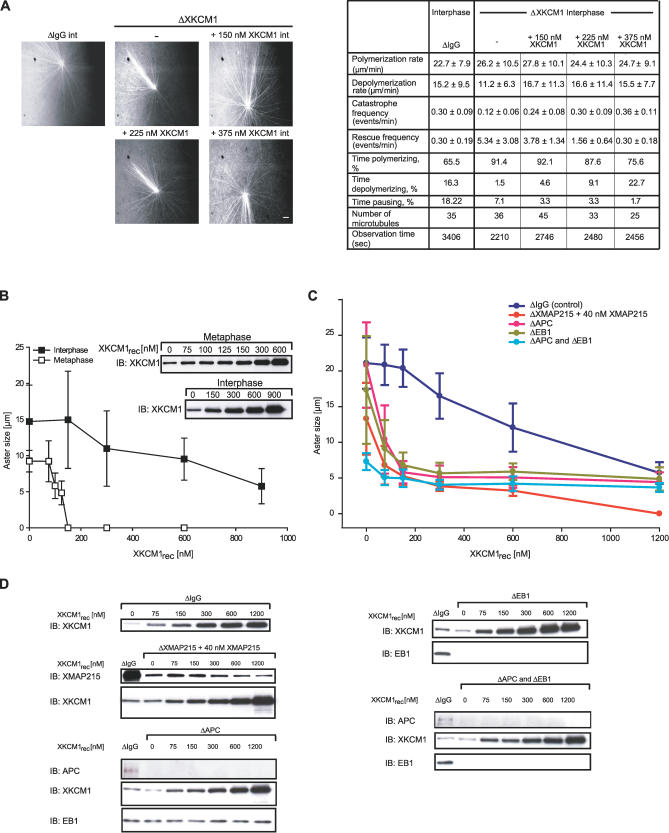
The MT Destabilizing Activity of XKCM1 Is Inhibited by MAPs in Interphase Egg Extracts(A) Still images and table summarizing the dynamic parameters of MT growth in response to XKCM1 depletion (ΔXKCM1) and add back of the recombinant protein.(B) Aster size after stepwise addition of recombinant XKCM1 into undepleted interphase and metaphase extracts. Error bars represent the S.D. (n > 30). Inset shows the Western blot of extracts containing increasing amounts of recombinant XKCM1 (XKCM1rec = amount of XKCM1 added in nM; and IB: XKCM1 = immunoblot with anti-XKCM1 antibody).(C) Aster size after stepwise addition of recombinant XKCM1 into control (IgG) depleted (indigo line), XMAP215 depleted plus 40 nM XMAP215 (red line), APC depleted (pink line), EB1 depleted (dark yellow line), and APC and EB1 depleted (cyan line) interphase extracts. Error bars represent the S.D. (n > 30).(D) Western blot of extracts containing increasing amounts of recombinant XKCM1 (XKCM1rec = amount of XKCM1 added in nM; and IB: XKCM1 = immunoblot with anti-XKCM1 antibody) that were depleted of specified MAPs.